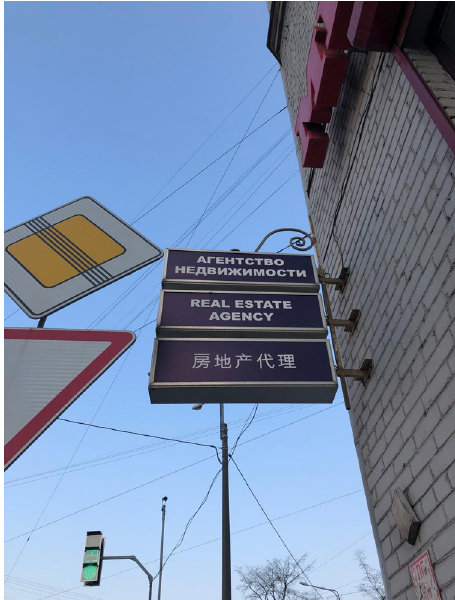
Figure 10: The sign for a real - estate agency, Shevchenko str., St. Petersburg, 2019, LinguaSnapp